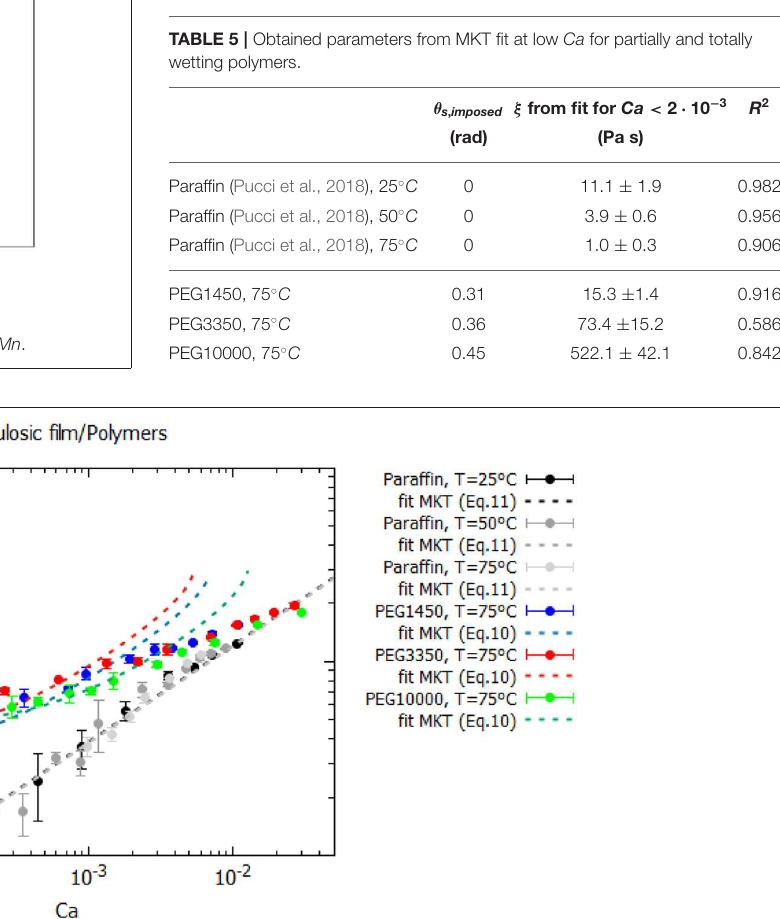
Frontiers in Materials |